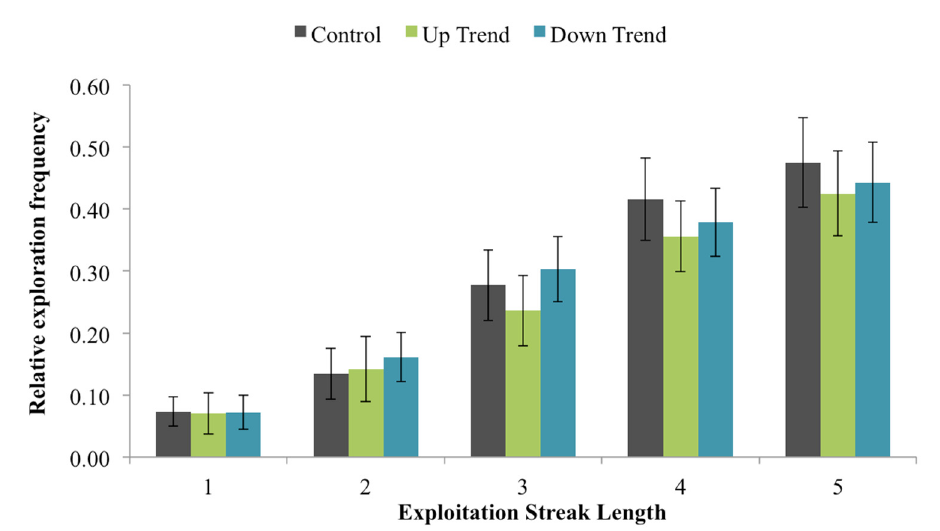
Figure 5. Subjects’ relative exploration frequency with different exploitation streak lengths. Error bars represent 95% confidence intervals for the mean values between